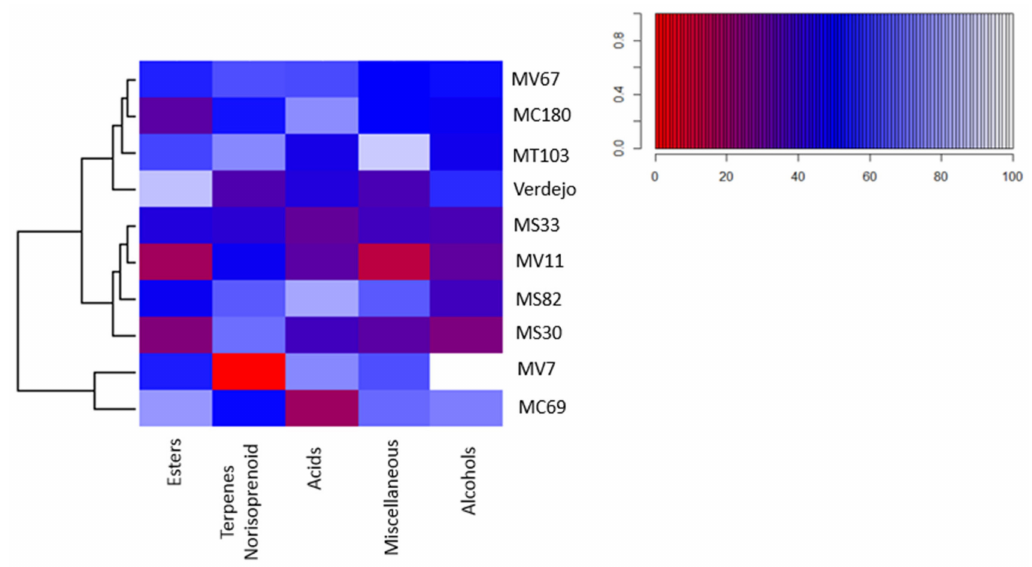
Figure 3. Heat map correlations for the di ff erent aromatic families with elements sorted according to a cluster analysis of the crosses and Verdejo. In brief, white colors indicate positive correlations, red colors indicate negative correlations, and blue colors indicate intermediate